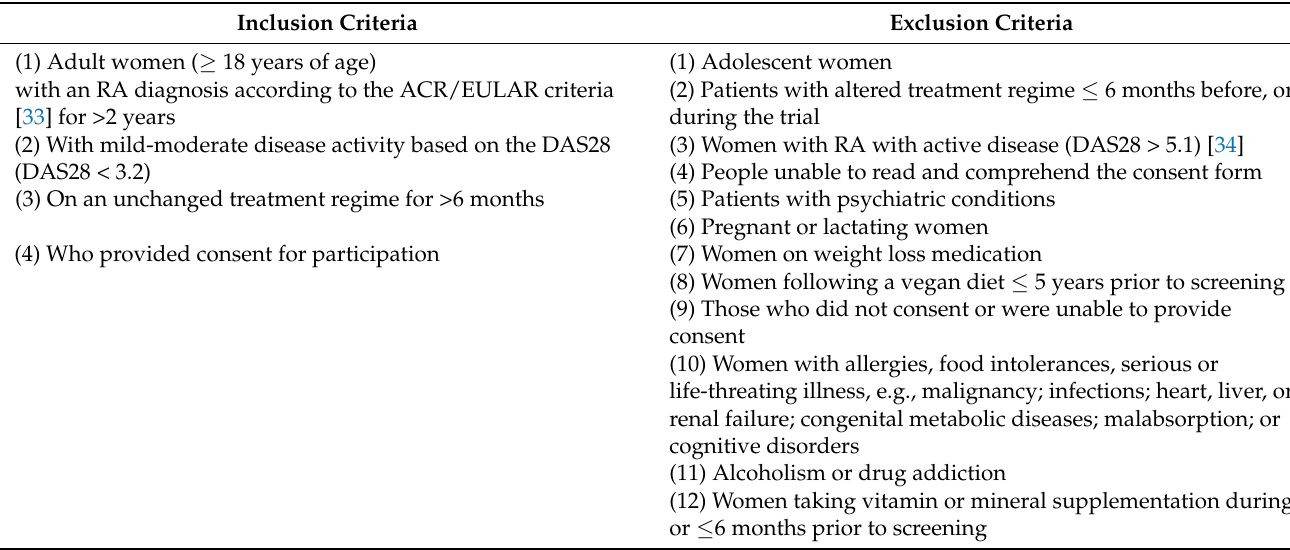
Table 1. Inclusion and exclusion criteria for participation in the